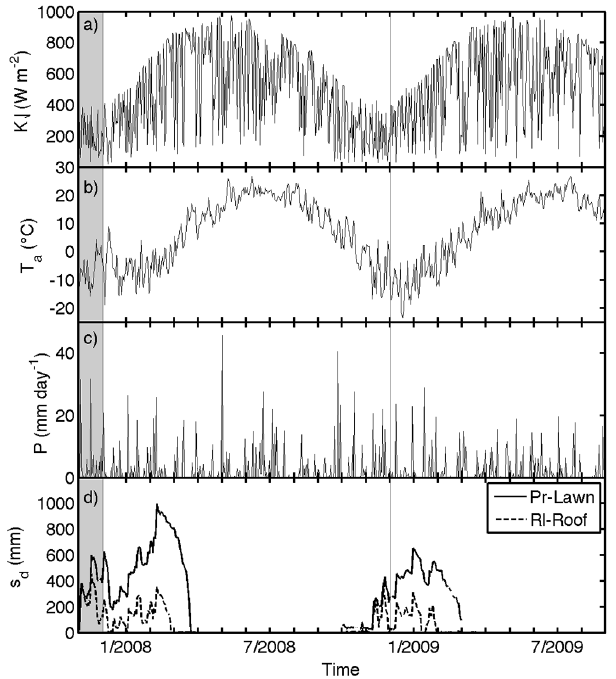
Figure 3. As Fig. 2 but for Montreal measured at the suburban site (Pr) with snow depth measured in a suburban back lawn (Pr) and on an urban roof